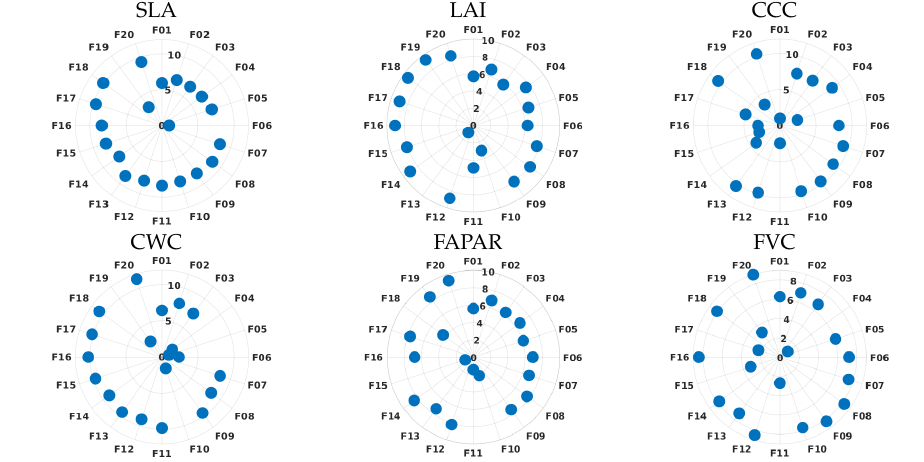
Figure 7. Polar plots for each variable using the GPR-20PCA models. All 20 components are displayed around the circumference. Distance to origin represents the importance of each component: the more outside, the more